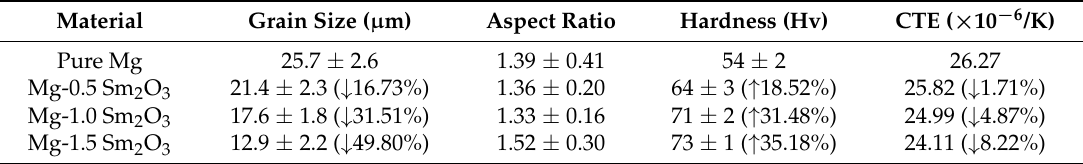
Table 1. Results of microstructure, coefficient of thermal expansion (CTE), and microhardness studies. Material